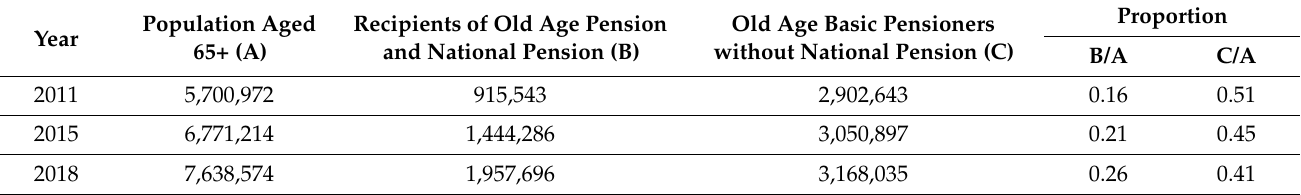
Table 5. Public pensioners among individuals aged 65 and